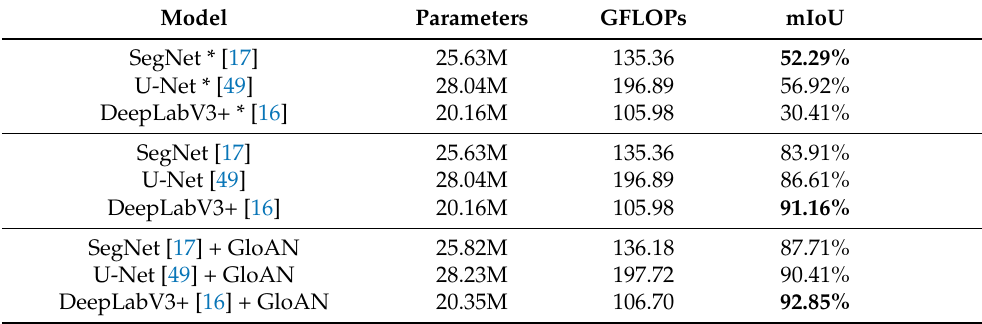
Table 1. Segmentation results on the rice lodging